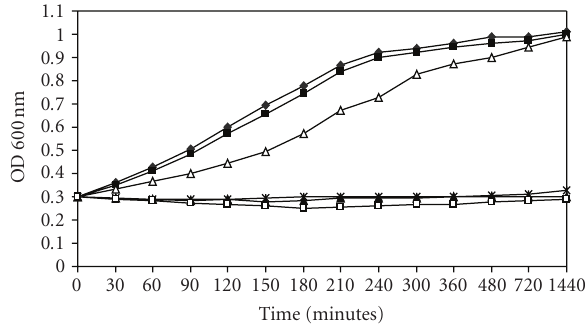
Figure 1: Growth curve for S. aureus strain ATCC 25923 in the presence or absence of CT. (cid:2) , S. aureus ATCC 25923 plus 1 μ g · mL CT; Δ , S. aureus ATCC 25923 plus 2 μ g · mL CT; ∗ , S. aureus ATCC 25923 plus 4 μ g · mL CT; (cid:3) , S. aureus ATCC 25923 plus 8 μ g · mL CT; (cid:4) , S. aureus ATCC 25923 plus 16 μ g · mL CT; (cid:5) , untreated S. aureus ATCC